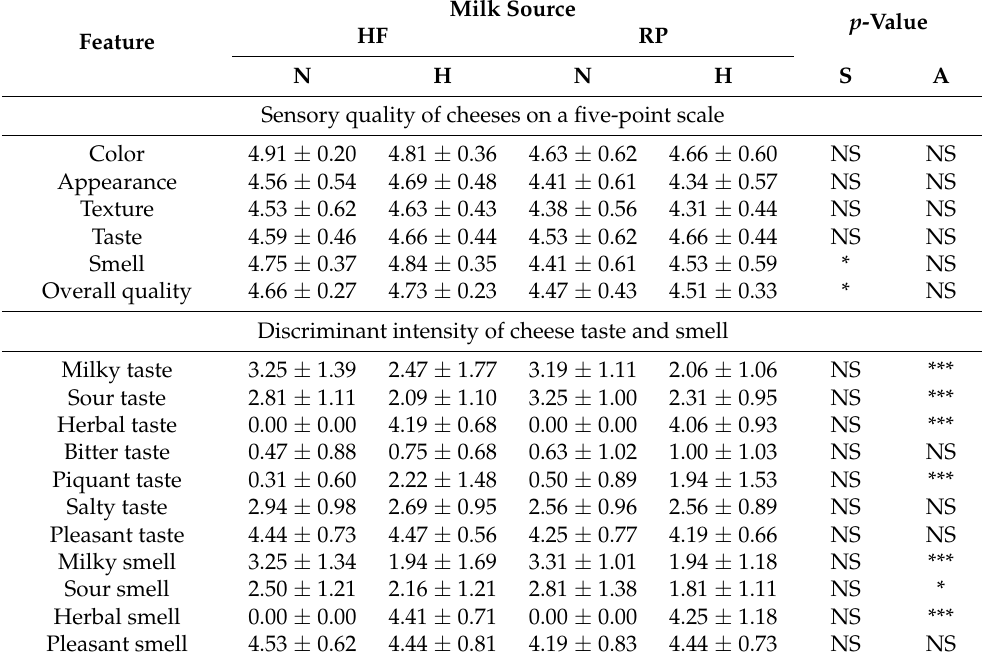
Abbreviations: HF—cheese from Polish Holstein-Friesian breed Black-and-White type milk; RP—cheese from Pol- ish Red breed milk; N—cheese with no wild garlic addition; H—cheese with wild garlic; S—breed effect;